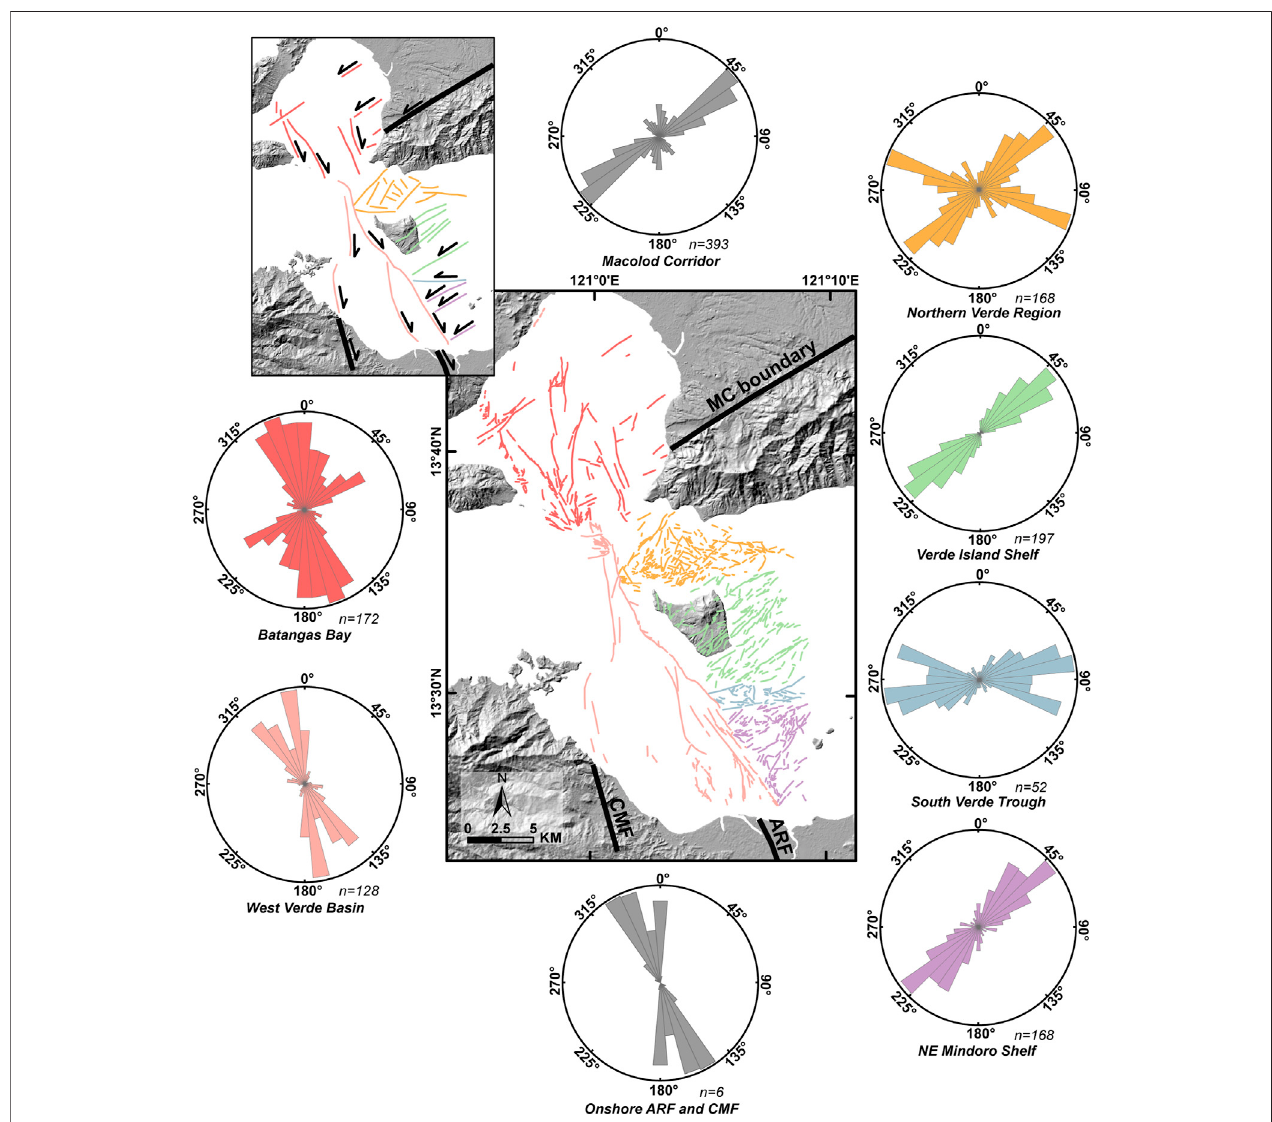
FIGURE 9 | Rose histograms of faults and lineaments showing a conjugate fault system in offshore southern Batangas. Inset shows simpli fi ed tectonic interpretation.